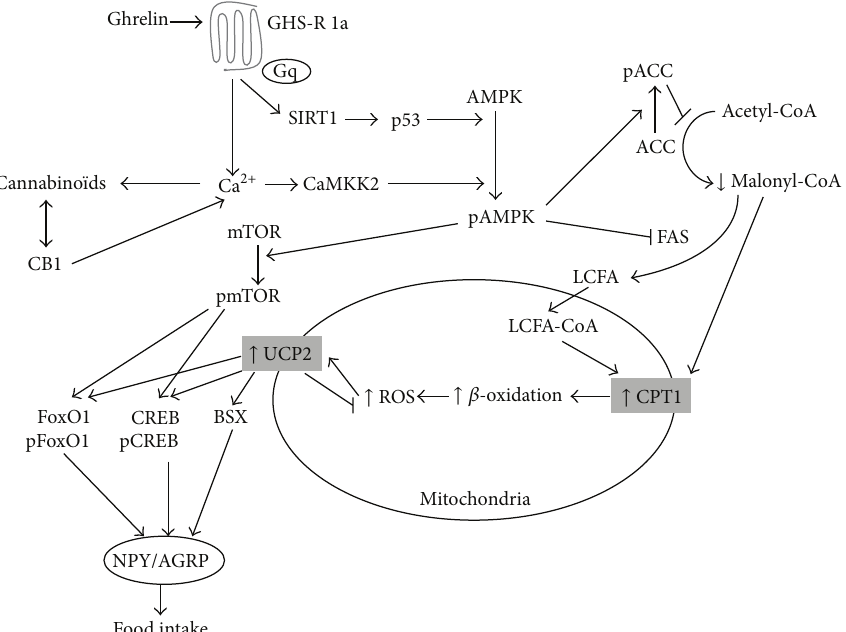
Figure 7: Molecular mechanisms leading to ghrelin-induced food intake in the hypothalamus. Intracellular signaling pathways and mitochondrial metabolism resulting in NPY/AGRP secretion consecutive to ghrelin receptor activation are schematized. ACC: acetyl coenzyme A carboxylase; AGRP: agouti-related protein; AMPK: 5 󸀠 adenosine monophosphate-activated protein kinase; BSX: brain- specific homeobox transcription factor; CaMKK2: calmodulin kinase-kinase 2; CB1: cannabinoid receptor type 1; CPT1: carnitine- palmitoyltransferase-1; CREB: cyclic adenosine 3 󸀠 ,5 󸀠 monophosphate response element-binding protein; FAS: fatty acid synthase; FoxO1: forkhead box protein O1; GHS-R1a: growth hormone secretagogue receptor type 1a; Gq: Gq protein; LCFA: long chain fatty acid;